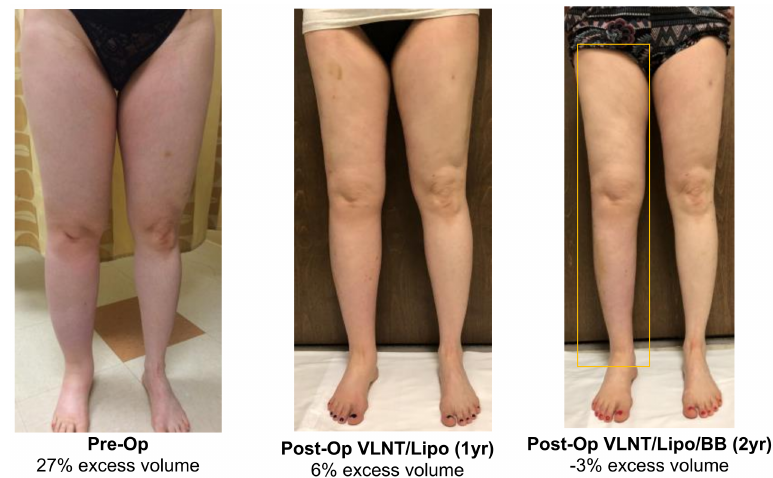
Figure 4. Lower extremity with 27% excess volume reduced to 6% at 12 months following VLNT and liposuction. BB placement at 1 year post-op resulted in volume excess improvement to − 3% at 24 months following triple therapy surgical management.